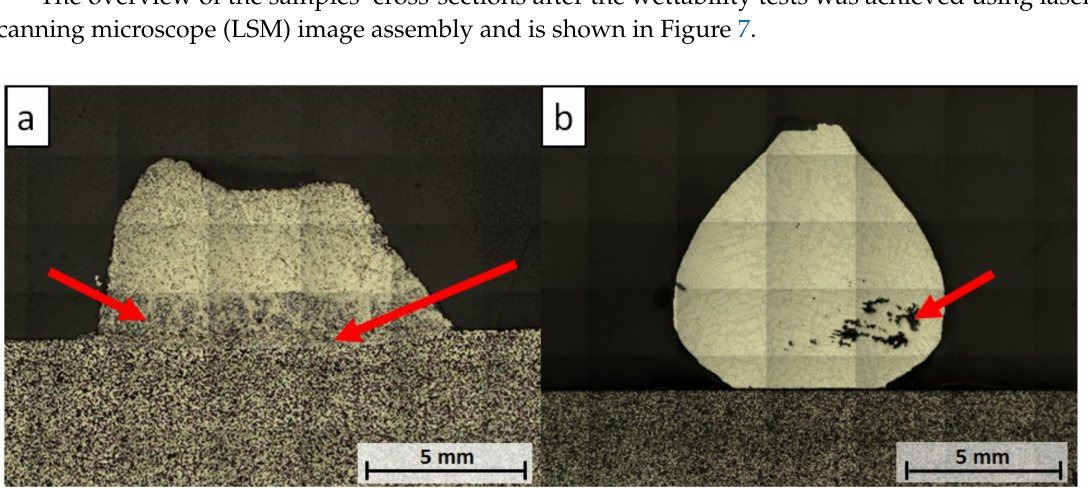
Figure 7. LSM image assembly micrographs of samples after wettability tests: ( a ) W_0; ( b ) W_850.